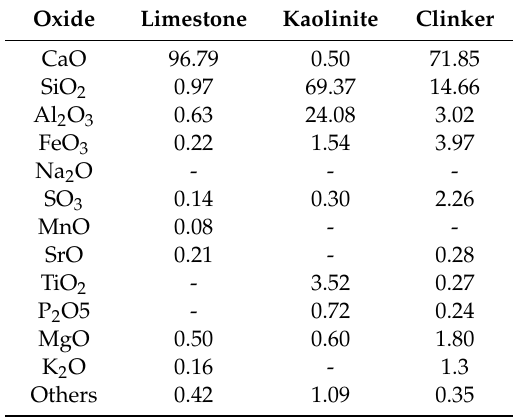
Table 1. Chemical composition of the raw materials and classic clinker.